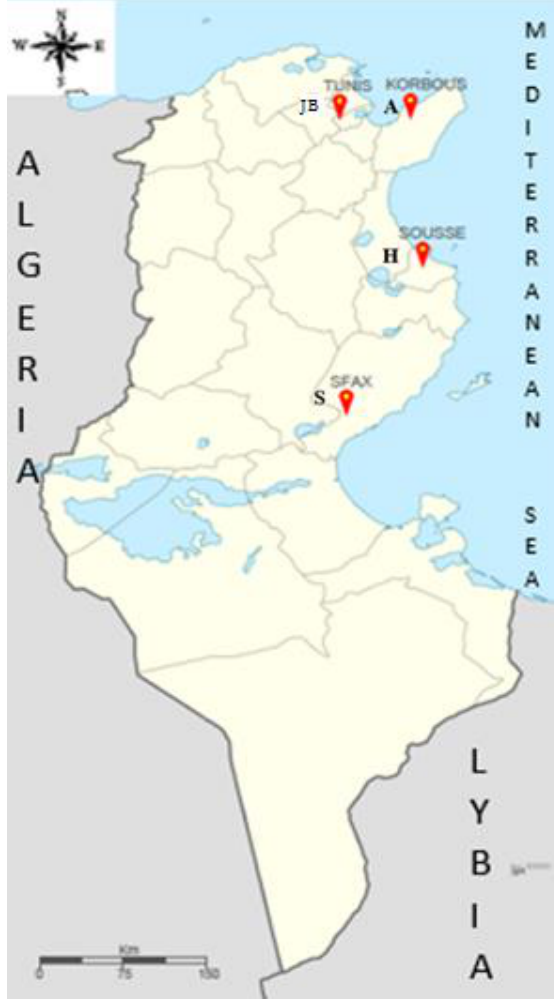
Figure 10. The geographical distribution of the sites in Tunisia.